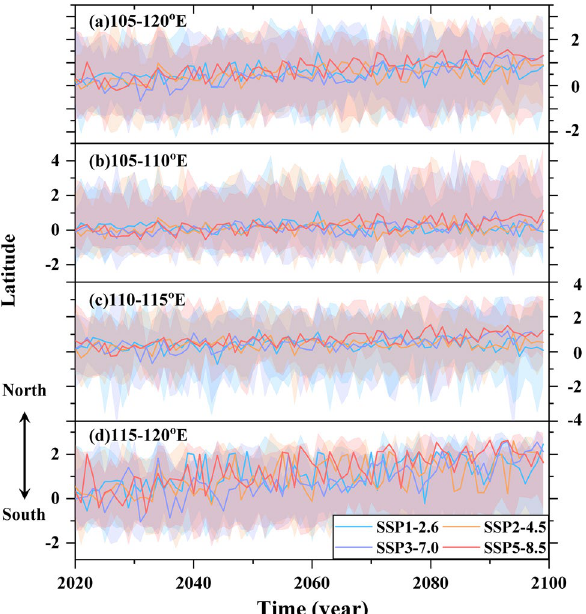
Figure 3. Temporal evolution of the meridional migration of the EASM northern boundary over eastern China since the twenty-first century compared to the present day within the region of ( a ) 105–120°E, ( b ) 105–110°E, ( c ) 110–115°E, ( d ) 115–120°E under SSP1-2.6 (cyan), SSP2-4.5 (orange), SSP3-7.0 (medium purple), and SSP5- 8.5 (red). Solid lines indicate the meridional migration of the EASM northern boundary (unit: degree), while shadings indicate the 20th and 80th percentiles of the individual models.